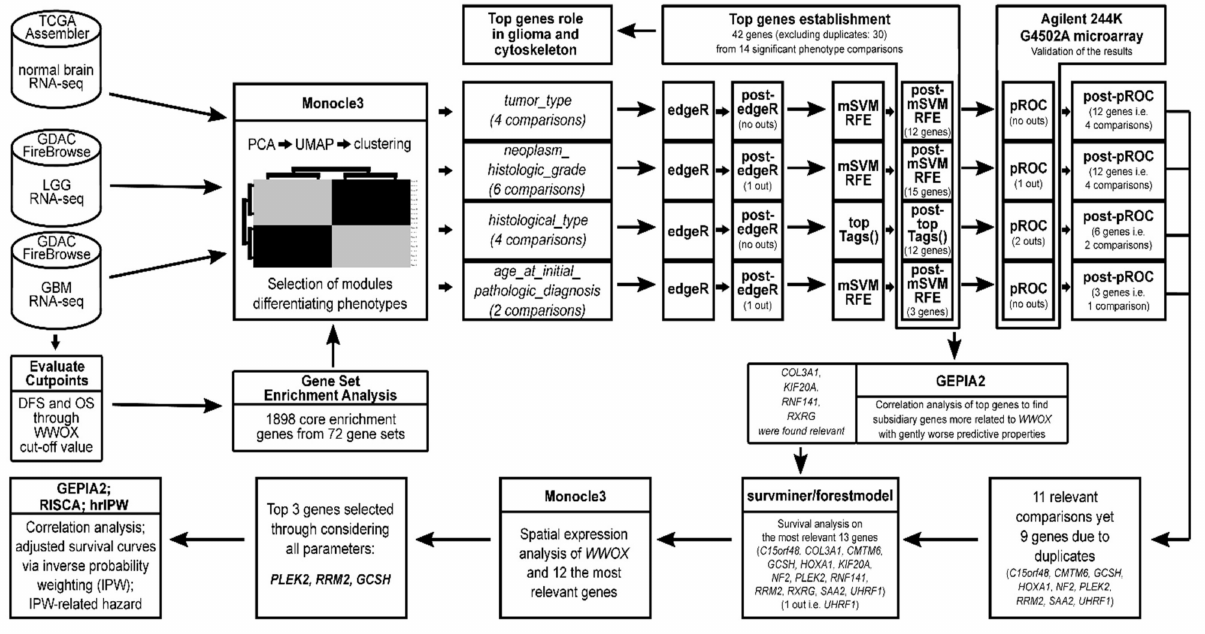
Figure 10. Methodology pipeline